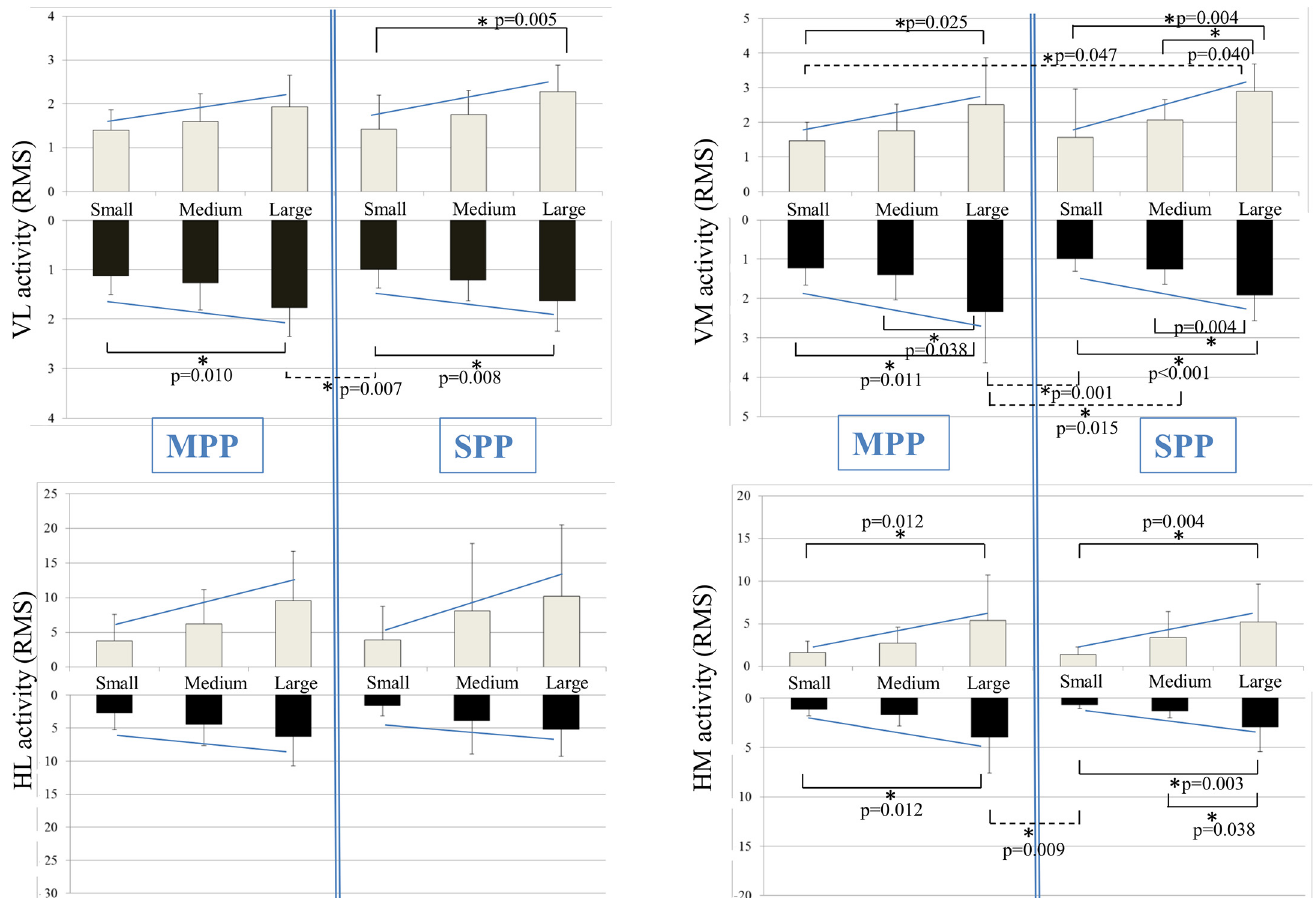
Fig 3. Visualisation of the average muscle activity of the VL, VM, HL and HM in the different conditions. The light colored bars represent the perturbation phase while the dark colored bars represent the response phase. Post-hoc Bonferroni tests revealed significant differences between conditions and are highlighted with an asterisk (p <